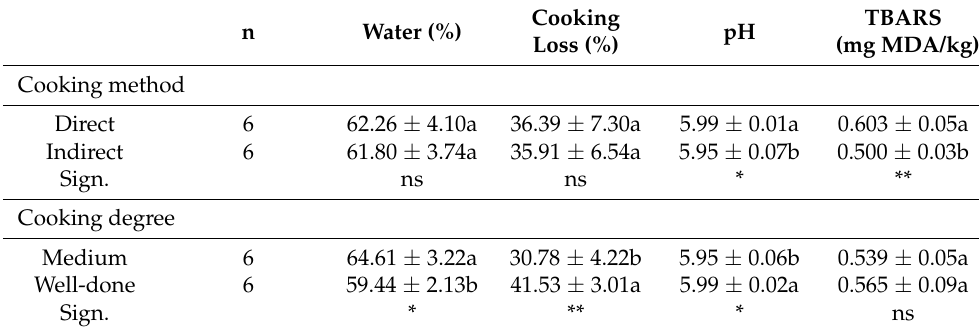
Table 1. The water content, cooking loss, and pH value of the meat samples cooked using direct and indirect cooking methods at different cooking degrees (mean ±